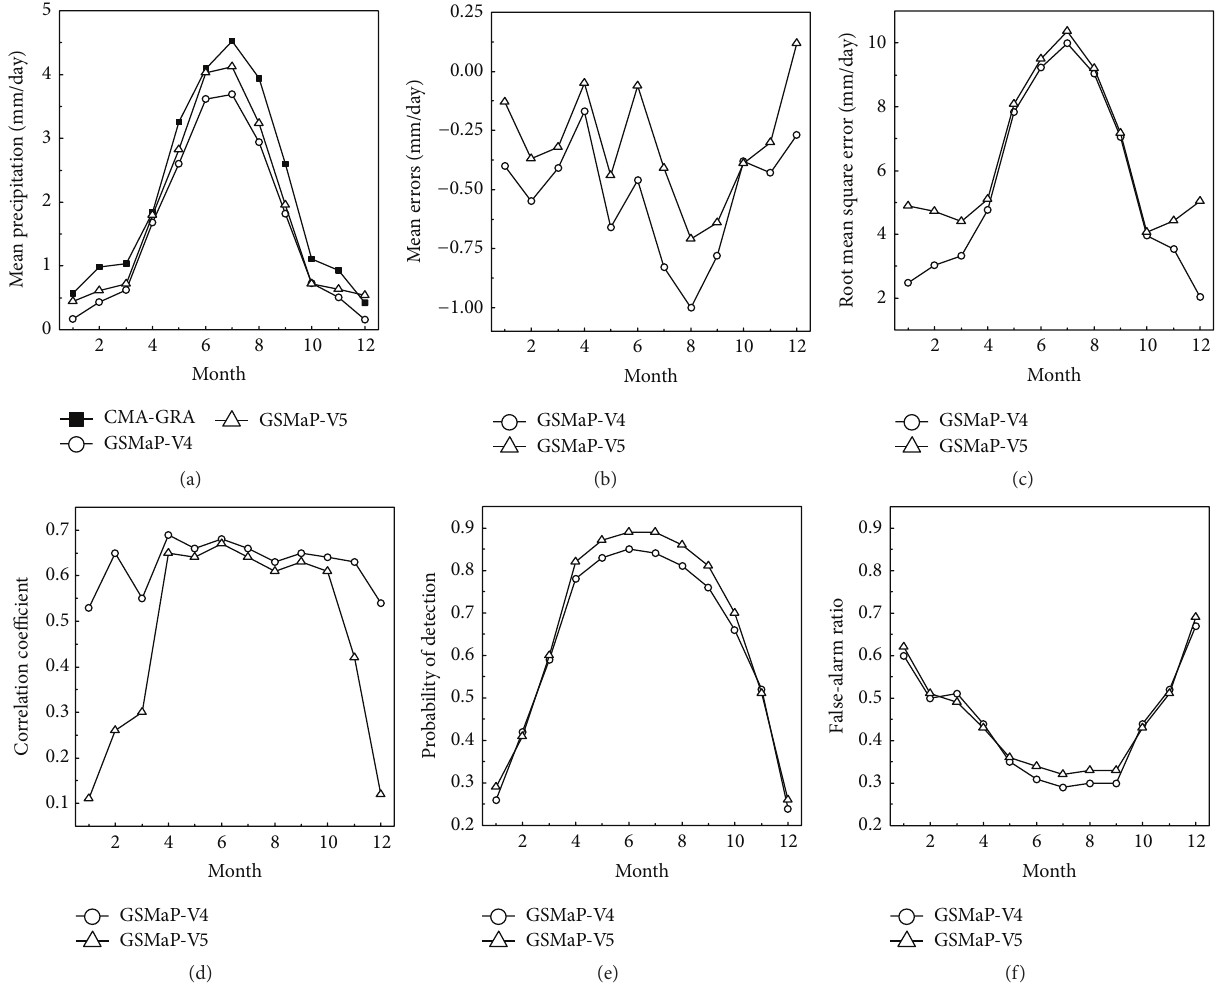
Figure 2: Seasonal variations of validation statistics of GSMaP products. (a) Mean precipitation, (b) mean errors, (c) root mean square error, (d) correlation coefficients, (e) probability of detection, and (f) false-alarm ratio.